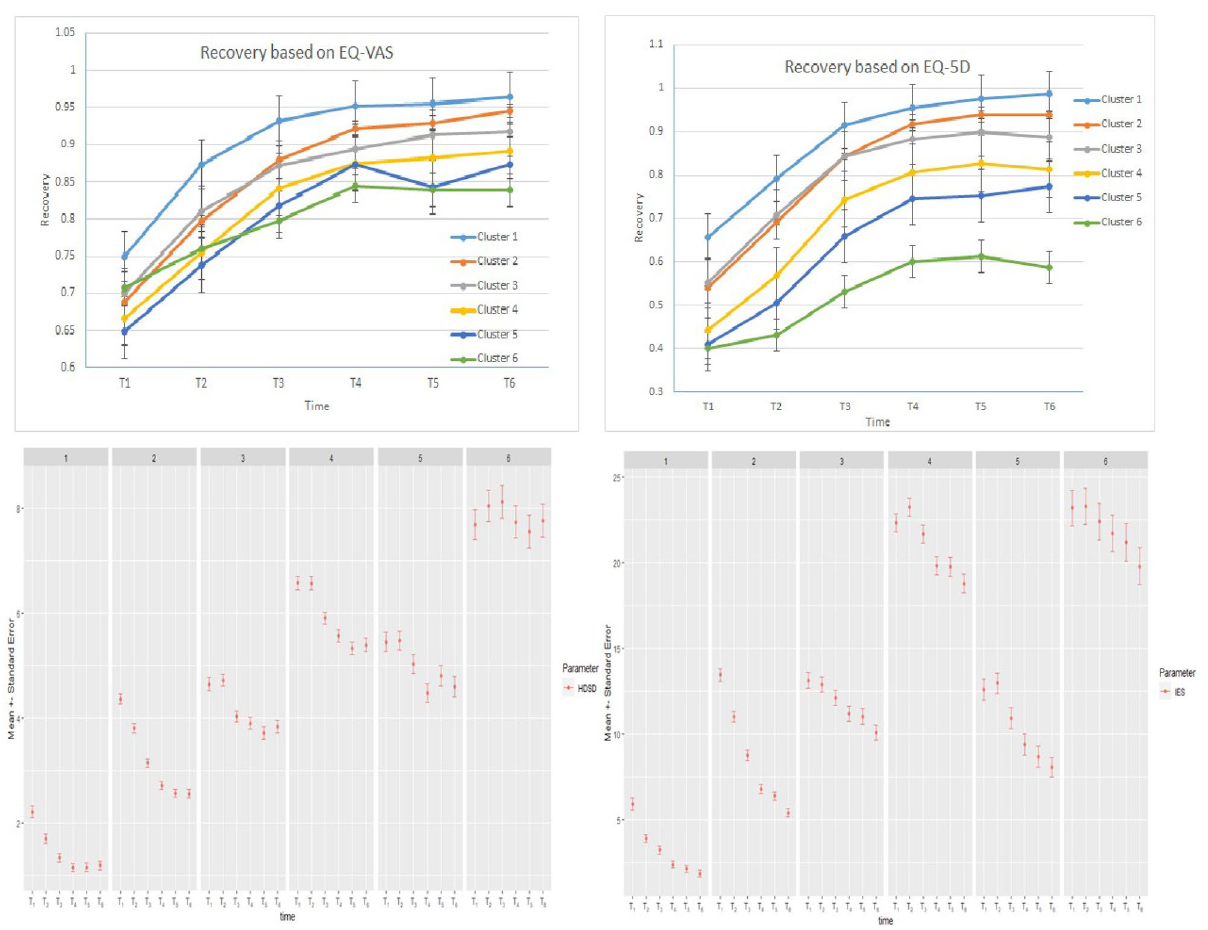
Figure 3. The two graphs at the top present recovery based on EQ-VAS and EQ-5D for the case of General Health with HDclassif. The two graphs at the bottom depict psychological condition (high values indicate high stress and anxiety) of various clusters after the